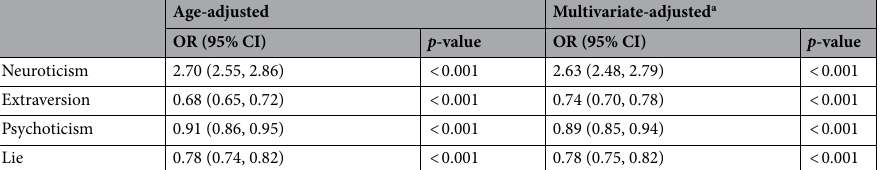
Table 2. Odds ratios (ORs) and 95% confidence intervals (CIs) for postpartum depressive symptoms for 1 standard deviation increase in each personality scale. Postpartum depressive symptoms were defined as a total score of the Japanese version of Edinburgh Postpartum Depression Scale ≥ 9. a Adjusted for age at delivery, parity, mode of delivery, educational attainment, household income, and social isolation during